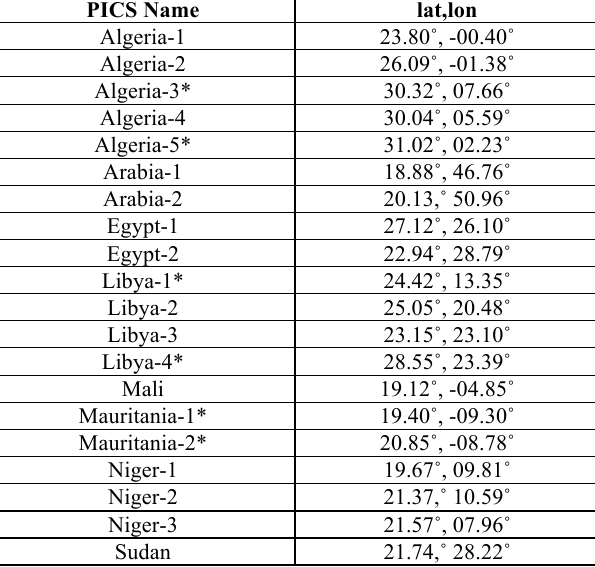
Table 1. List of 20 PICSs with geographic coordinates of their centres. The 6 recommended PICS by CEOS are marked by *. A widow of 10x10km pixels is centred to subset the data.